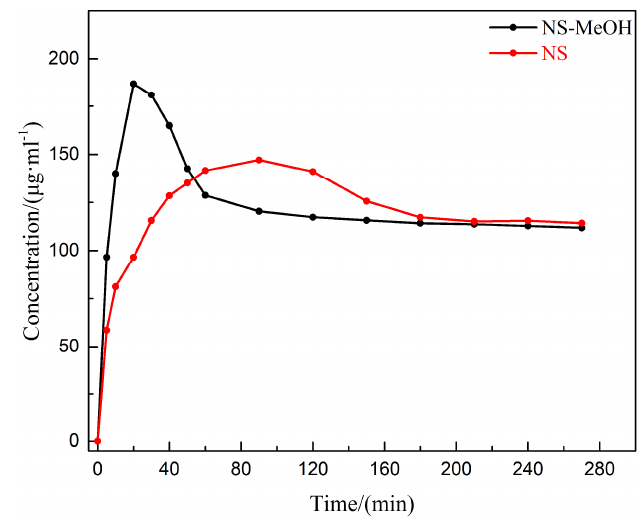
Figure 11. Plot of dissolution of NS and NS-MeOH.